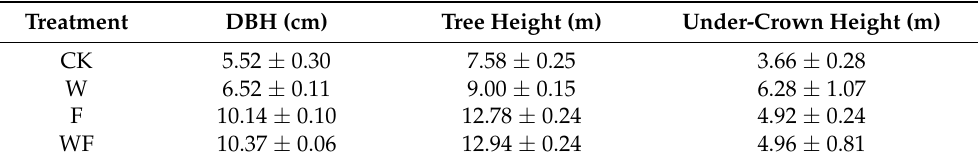
Table 2. The diameter at breast height (DBH), tree height and under-crown height of standard trees felled in May 2019 with different treatments.